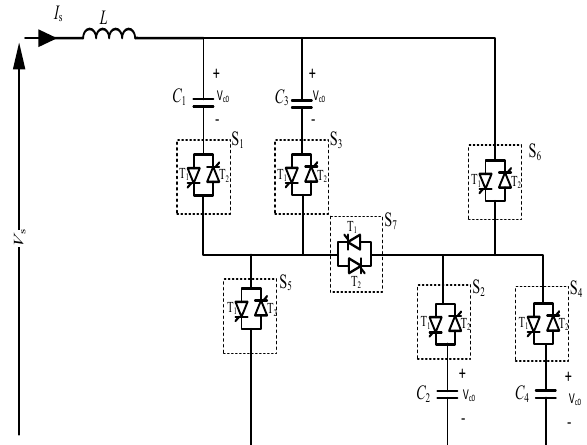
Fig. 2. TSC with 25 power